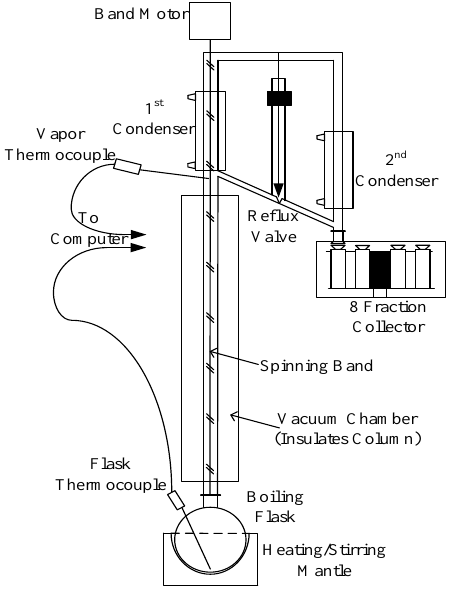
Figure 4. Diagram of the initial acetic acid recovery step using a lab-scale recycle distillation system.